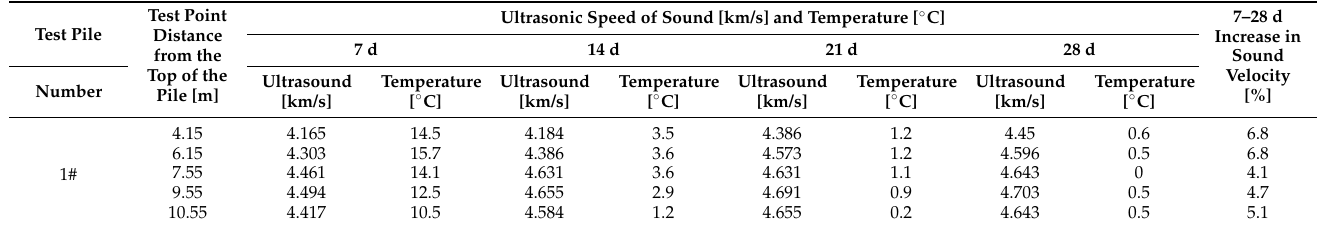
Table 5. 1# test pile frozen 7–28 d ultrasonic sound velocity and temperature record sheet.